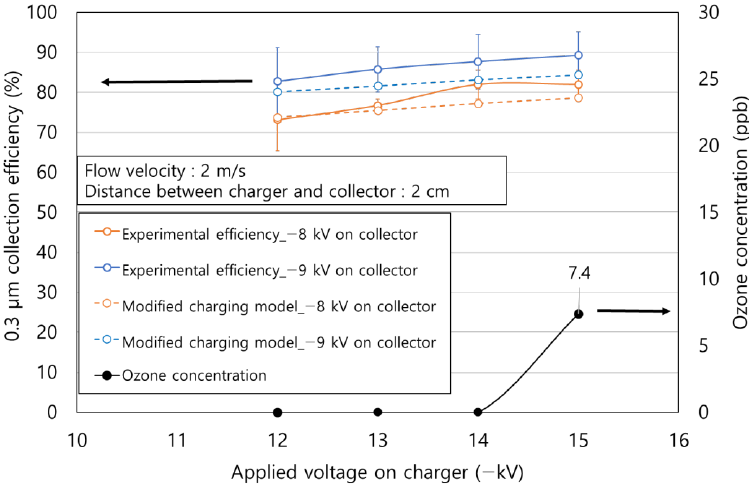
Figure 10. Comparison of the experimental efficiency and modified charging model according to the applied voltages.